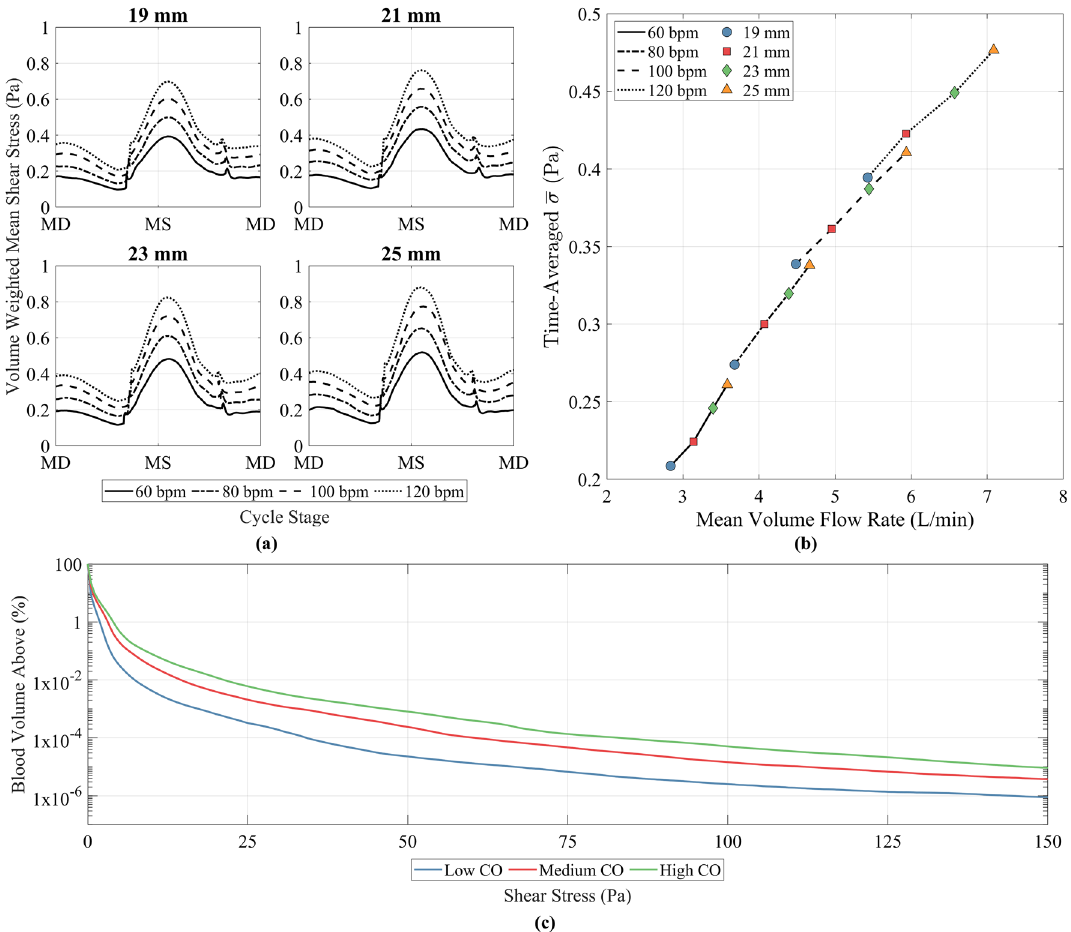
Figure 7. ( a ) Volume-weighted mean scalar shear stress ( σ ) against time for the different conditions simulated. MD refers to mid diastole whilst MS refers to mid systole. ( b ) Time-averaged σ against mean volume flow rate for each of the conditions simulated. ( c ) Average percentage volume of blood exposed to a given shear stress over the course of one cycle. Low CO was 60 bpm 19 mm (3 L/min), medium CO was 100 bpm 21 mm (5 L/ min) and high CO was 120 bpm 25 mm (7